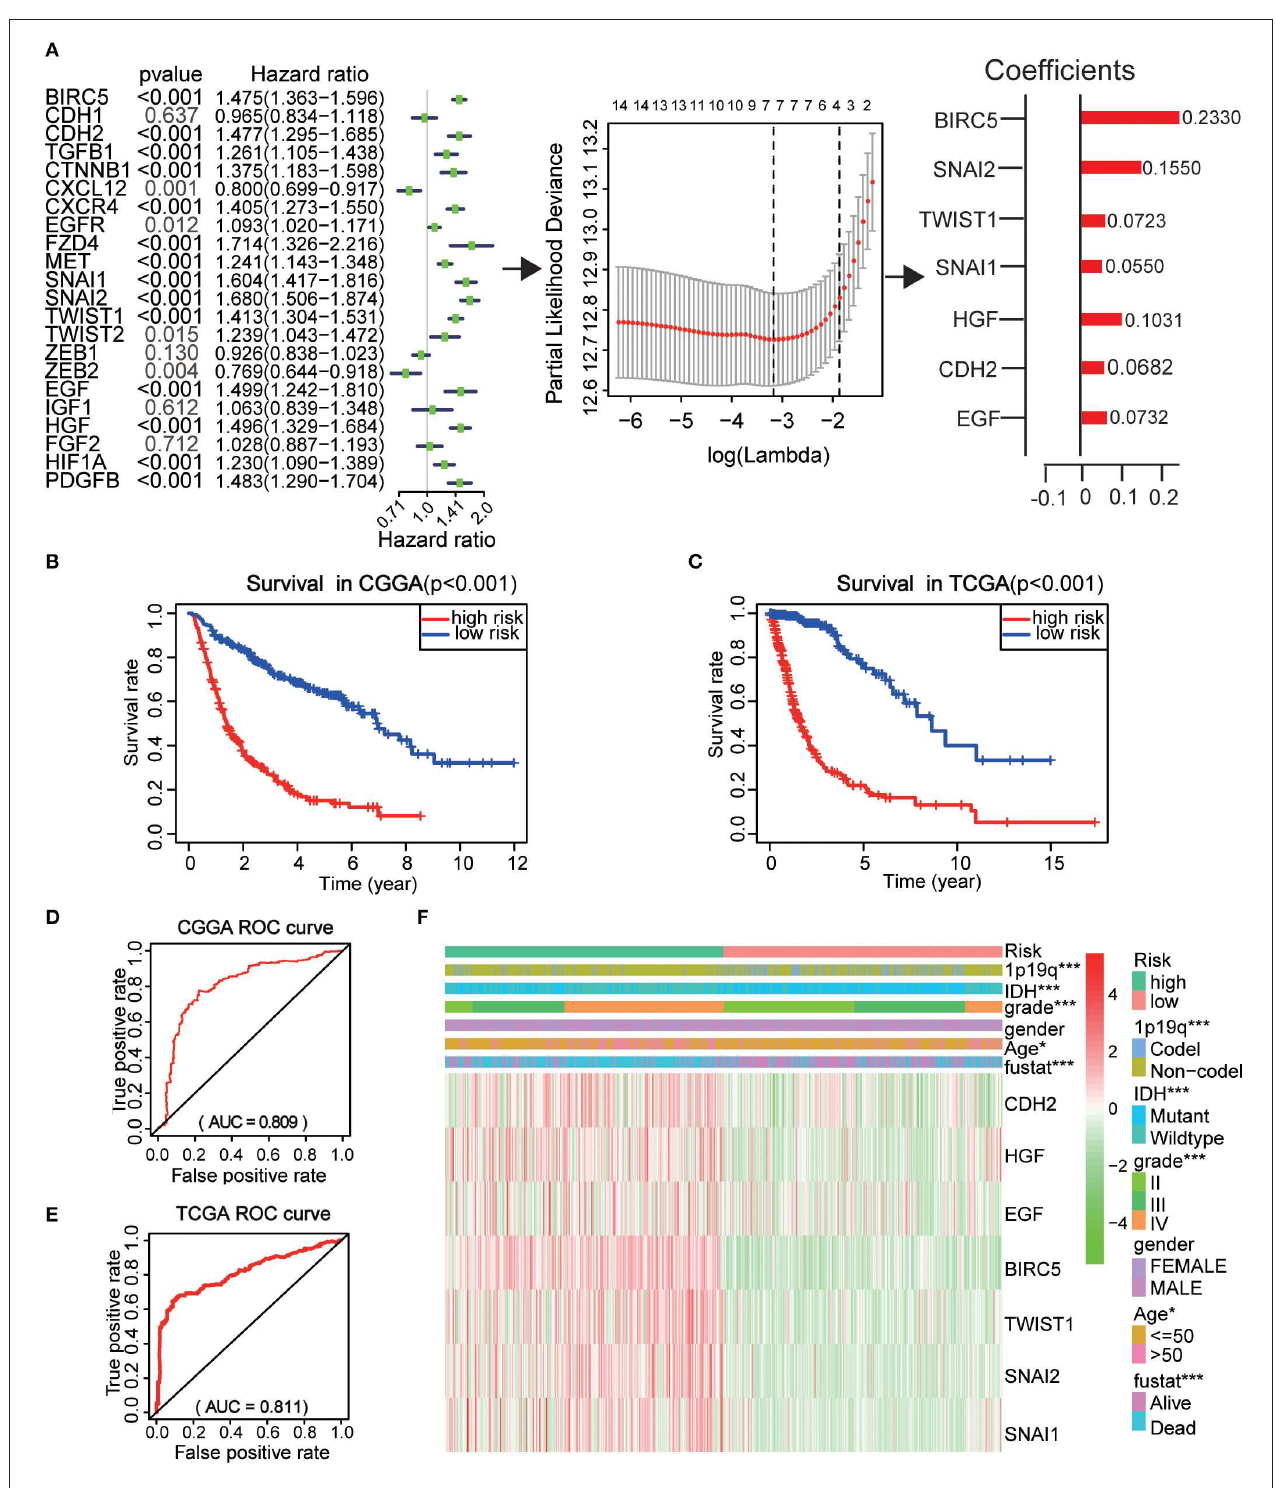
FIGURE 6 | Risk signature with seven EMT related genes. (A) The process of using seven genes to building the signature. (B,C) Kaplan–Meier overall survival (OS) curves for patients in the CGGA (B) and TCGA (C) datasets assigned to high- and low-risk groups based on the risk score. (D,E) The ROC curves of the risk signature in CGGA 9 (D) and TCGA (E) datasets. (F) The heatmap of the seven EMT related genes in low- and high-risk gliomas. The distribution of clinicopathological features was compared between the low- and high-risk groups. * P < 0.05 and *** P < 0.001.